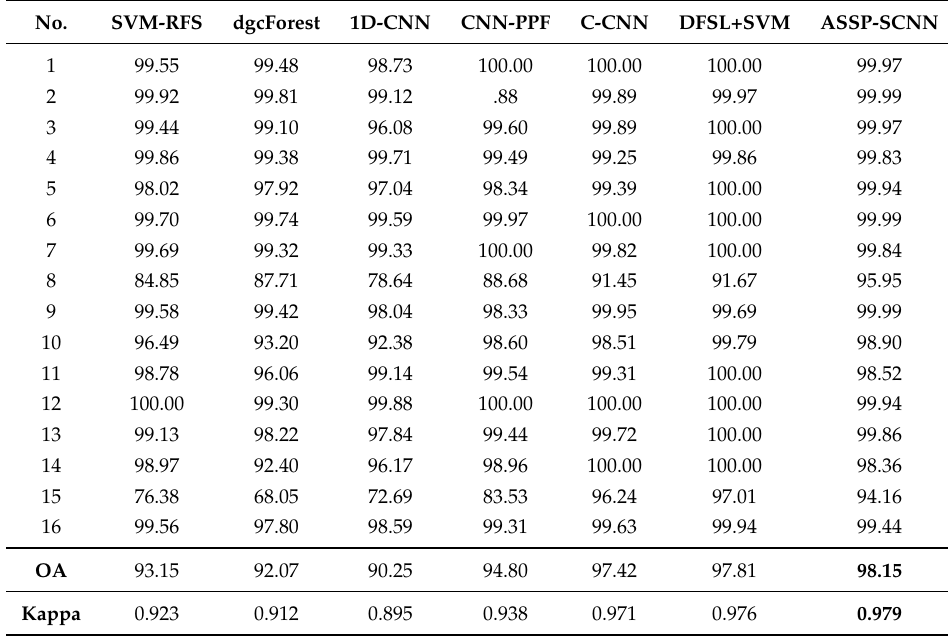
Table 10. Class-specific accuracy (%), OA (%) and Kappa coefficient of ASSP-SCNN and the comparing methods on Salinas dataset with sixteen